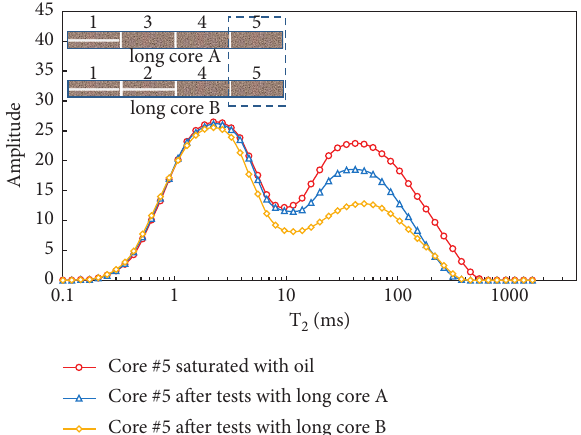
Figure 8: The difference between remaining oil distributions of core #5 after the huff-and-puff process with long core A and long core B.